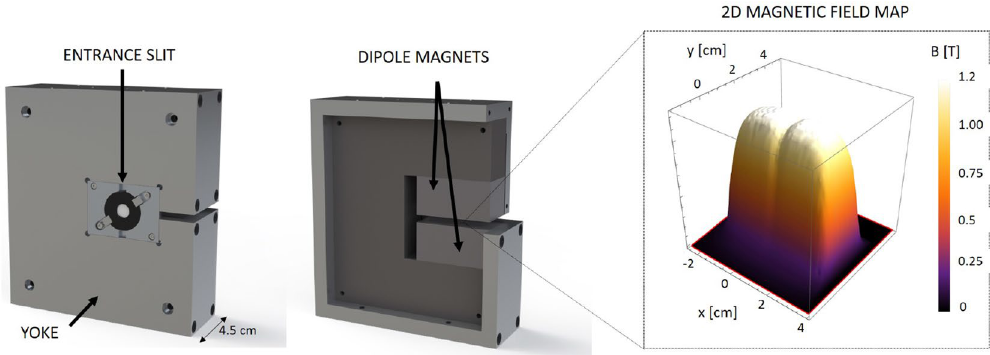
Figure 9. The design of magnet with entrance slit for the energy selector. 2D plot of the magnetic field generated by the dipole